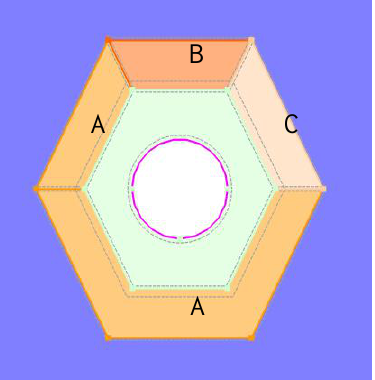
Figure 8. Schematic diagram of simulated nonwoven geotextile with different obtained permeability.